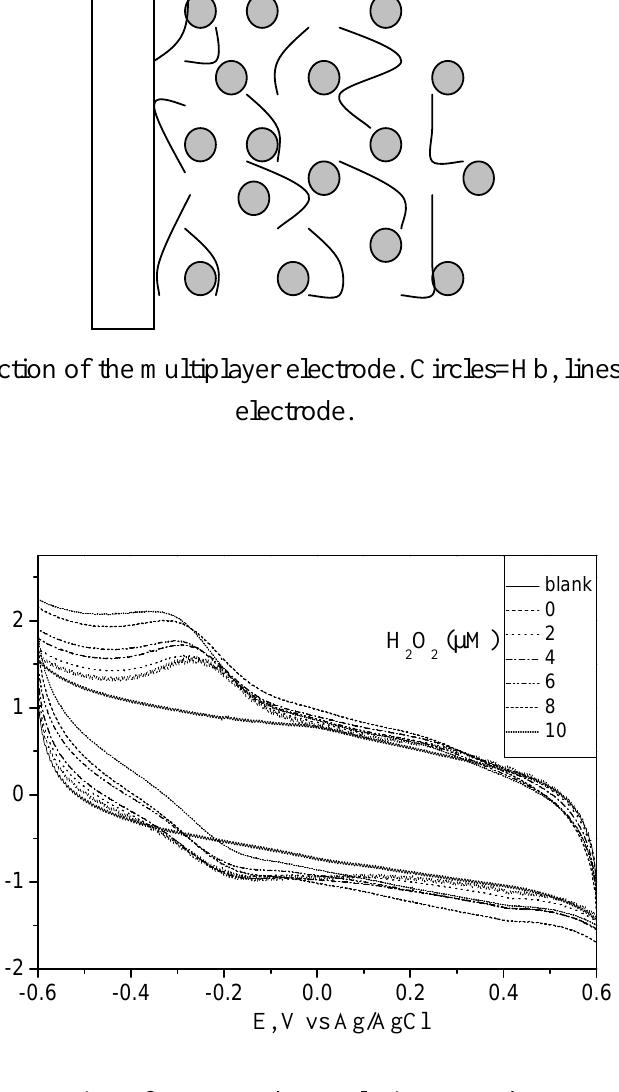
O on the catalytic CV peak at 0.3V/S for SPAN/HB=1:1 at 2 2 pH